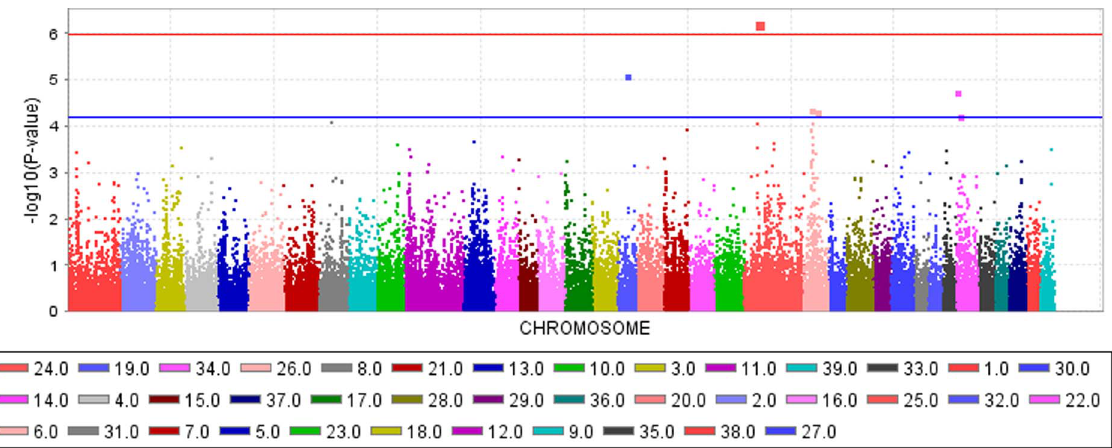
Figure 1. Manhattan plot of –log 10 P-values of the genome-wide association study for the canine hip dysplasia score in German Shepherd Dogs using a mixed linear model analysis. On the X-axis, the SNPs are given by dog chromosome number. The –log 10 P-values for each SNP genotype effect are plotted against the SNP position on each chromosome. Chromosomes are differentiated by colors. The color keys are given below the plot. The red line indicates a –log 10 P-value of 4.3 and the blue line indicates the threshold of the –log 10 P-values for genome-wide significance after correcting for multiple testing.